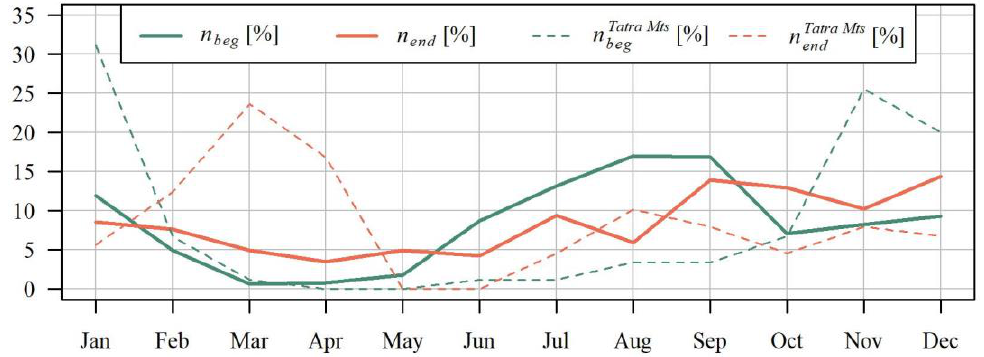
Figure 6. Distribution in the year of the mean relative number of the maximum drought beginning t beg and end t end in the studied area and TatraMts between 1991 and 2020.